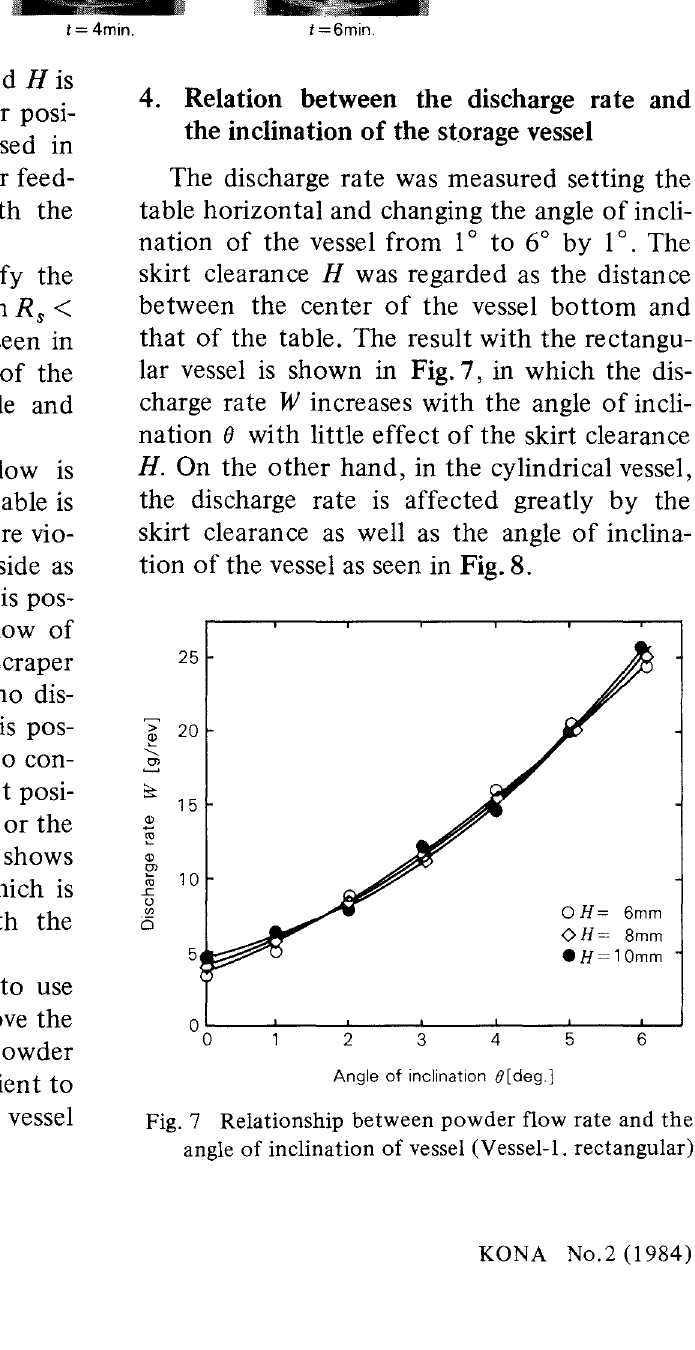
Fig. 6 Effect of scrapers on the flow pattern (two scrapers are utilized, one is behind the storage vessel)